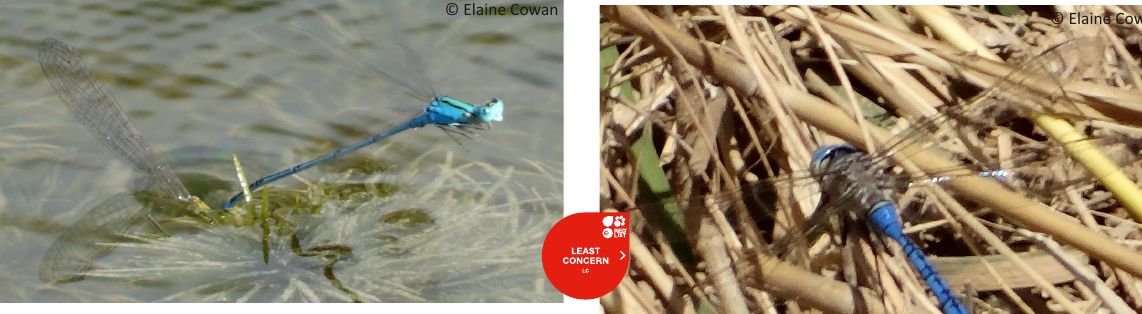
Image 7. Pseudagrion decorum pair in tandem, egg-laying female almost totally submerged, 16 November 2013